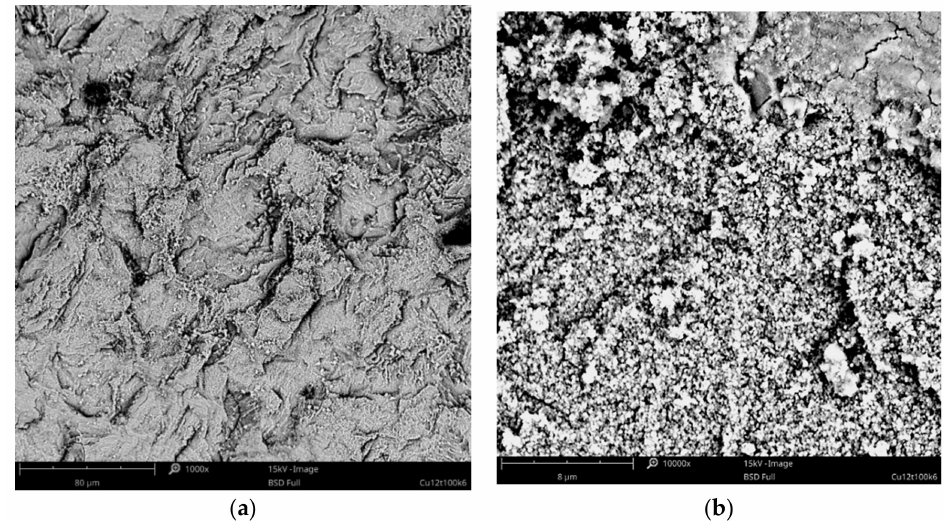
Figure 3. SEM images of the Cu coating electrodeposited in the bath with 30 g · L − 1 of CuAc at a temperature of 100 ◦ C (j c = 12 mA cm − 2 , t = 7.5 min) at low ( a ) and high ( b ) magnification.